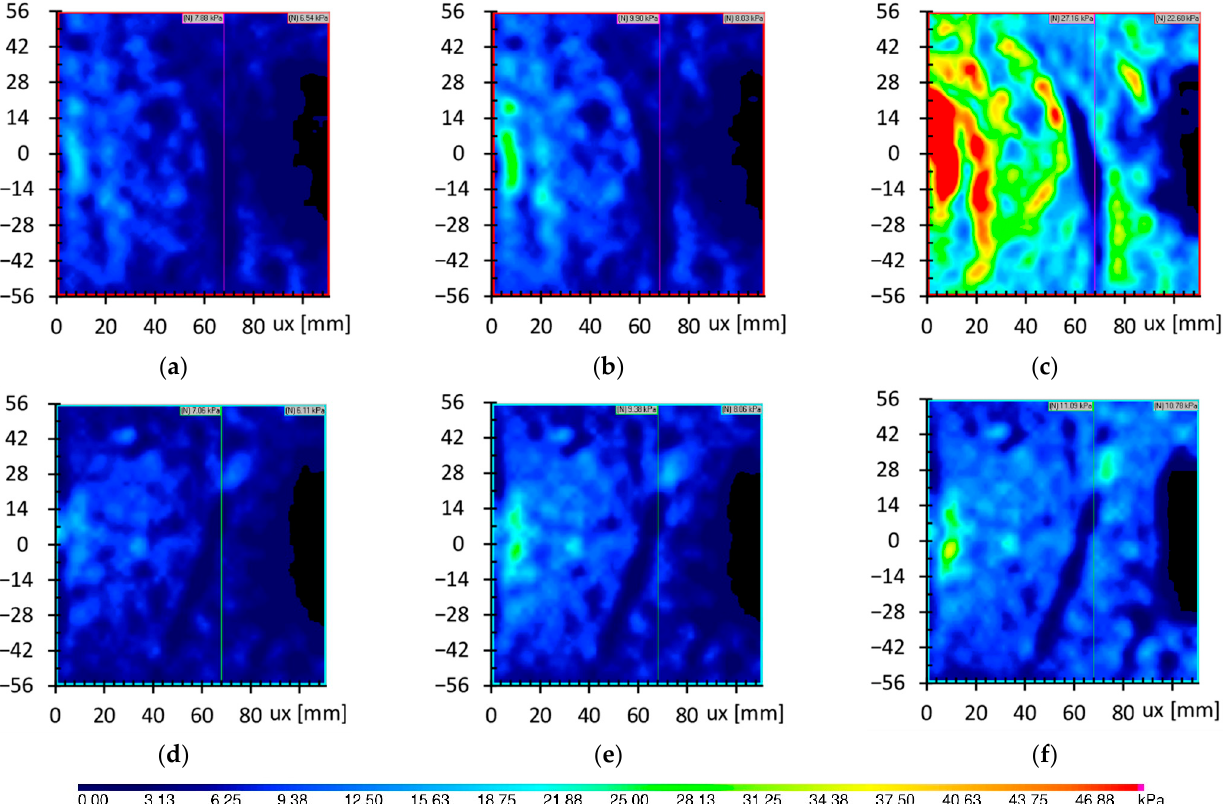
Figure 21. Pressure maps from test P1.R.0.5H.TS and P3.S.0.5H.TS in three different average stresses. Piles were placed in the middle of left maps edge, ux—distance from the pile skin. ( a ) P1.R.0.5H.TS-7.88 kPa; ( b ) P1.R.0.5H.TS– 9.90 kPa; ( c ) P1.R.0.5H.TS–27.16 kPa; ( d ) P3.S.0.5H.TS-7.06 kPa; ( e ) P3.S.0.5H.TS–9.38 kPa; ( f ) P3.S.0.5H.TS–11.09